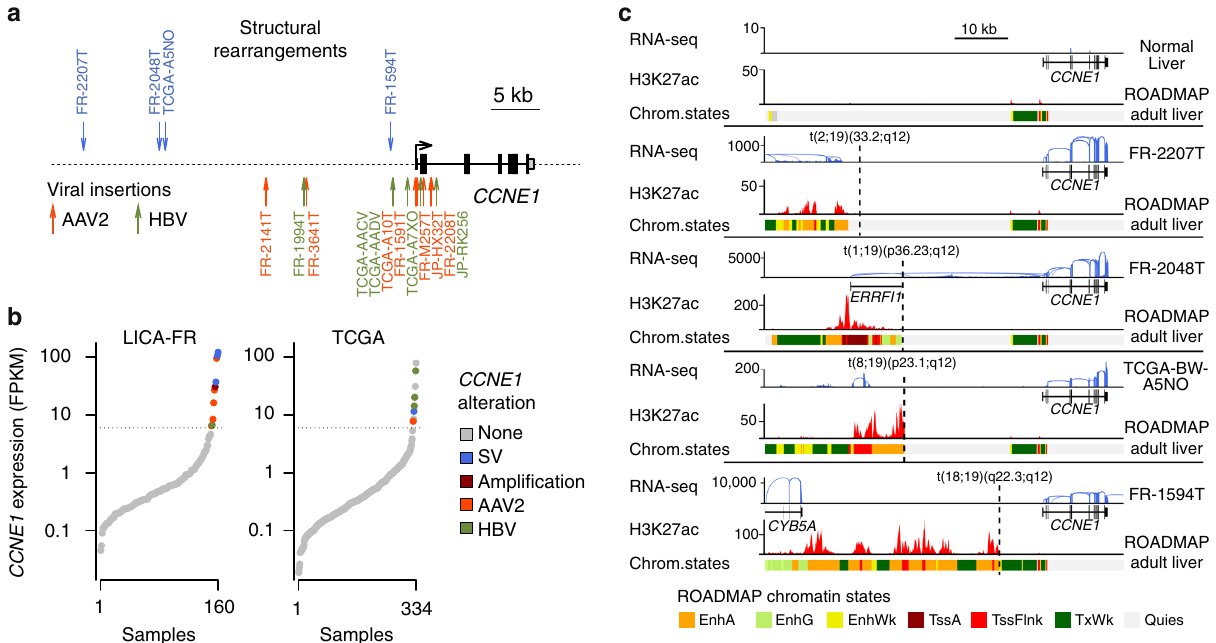
Fig. 2 Viral and non-viral mechanisms of CCNE1 activation in HCC. a Summary of structural rearrangements (top) and viral insertions (bottom) affecting CCNE1 gene identi fi ed in 751 HCC from the LICA-FR, TCGA and ICGC-JP cohorts. b Sorted CCNE1 expression (log scale) in the LICA-FR and TCGA cohorts. Gene expression was obtained from RNA-seq data and is given in fragments per kilobase of exons per million reads (FPKM). Samples harboring structural variants (SV), focal ampli fi cations and viral insertions are indicated with a color code. c Functional consequences of structural rearrangements affecting CCNE1 regulatory region. RNA-seq read counts along CCNE1 locus are represented in normal liver (top) and in 4 tumors harboring structural rearrangements upstream CCNE1 trancription start site (TSS). H3K27Ac chromatin immunoprecipitation sequencing (ChIP-seq) signal and chromatin states in adult liver were obtained from the ROADMAP consortium and are depicted below each reconstruted DNA sequence. EnhA: active